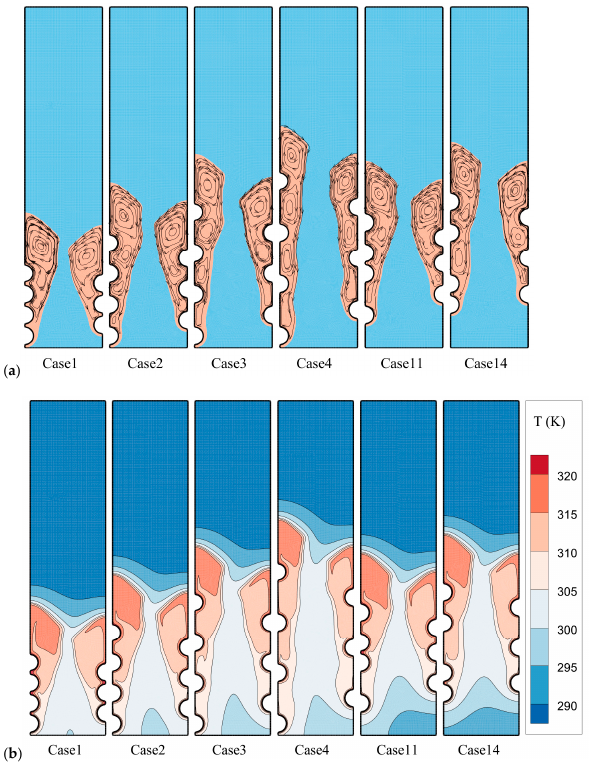
Figure 7. The melting behavior of the unit after one hour: ( a ) The streamlines and melting field; ( b ) the isotherms.